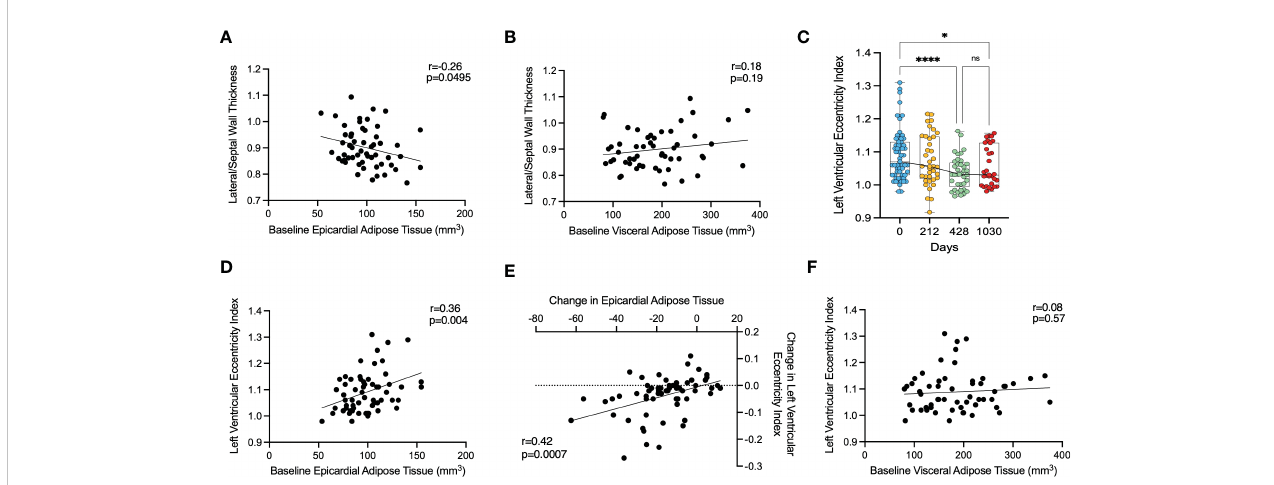
FIGURE 4 The effect of epicardial adipose tissue on cardiac geometry following bariatric surgery. (A) – correlation between baseline lateral/septal wall thickness ratio and baseline epicardial adipose tissue, (B) – correlation between baseline lateral/septal wall thickness ratio and baseline visceral adipose tissue, (C) – change in left ventricular eccentricity index, (D) - correlation between left ventricular eccentricity index and baseline epicardial adipose tissue, (E) - correlation between change in left ventricular eccentricity index and change in epicardial adipose tissue, (F) – correlation between left ventricular